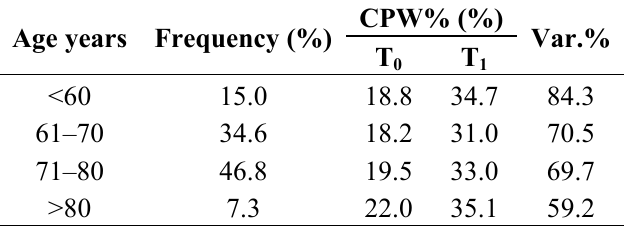
Table 3. Recovery of epidermal hydration.